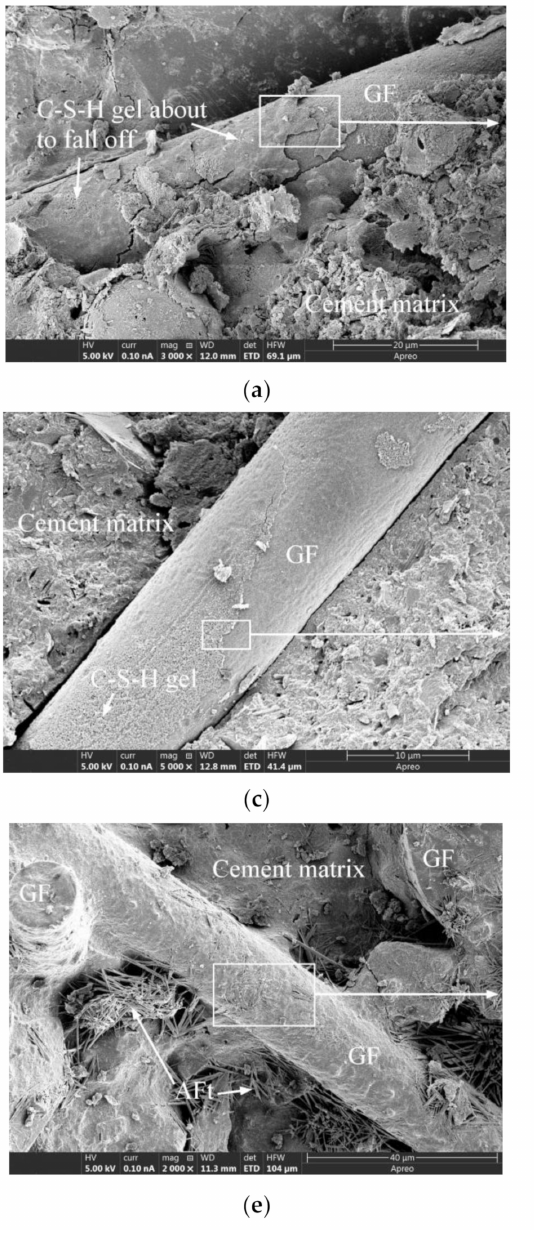
Figure 11. The SEM images of GFRC specimens after freeze-thaw cycles: ( a ) GF-30-135; ( b ) GF-30-135; ( c ) GF-30-90; ( d ) GF-30-90; ( e ) GF-30-135; ( f )